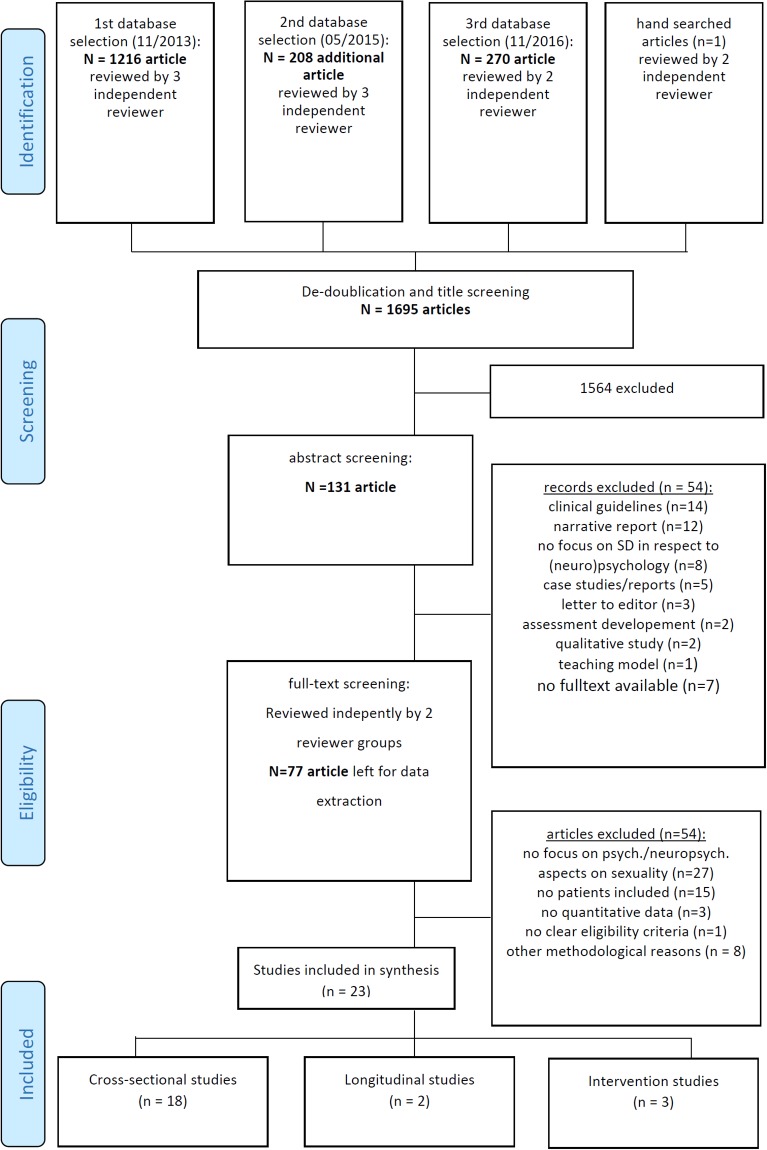
Data selection flow.